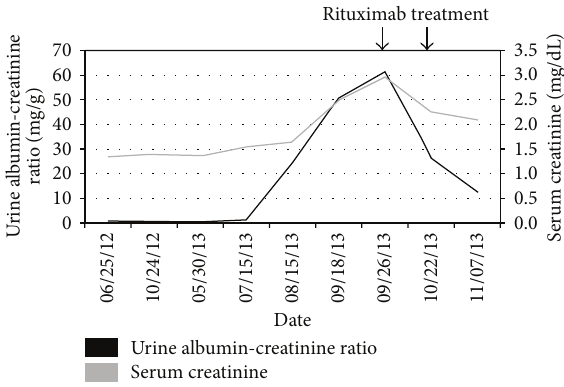
Figure 1: Time course of proteinuria and serum creatinine.